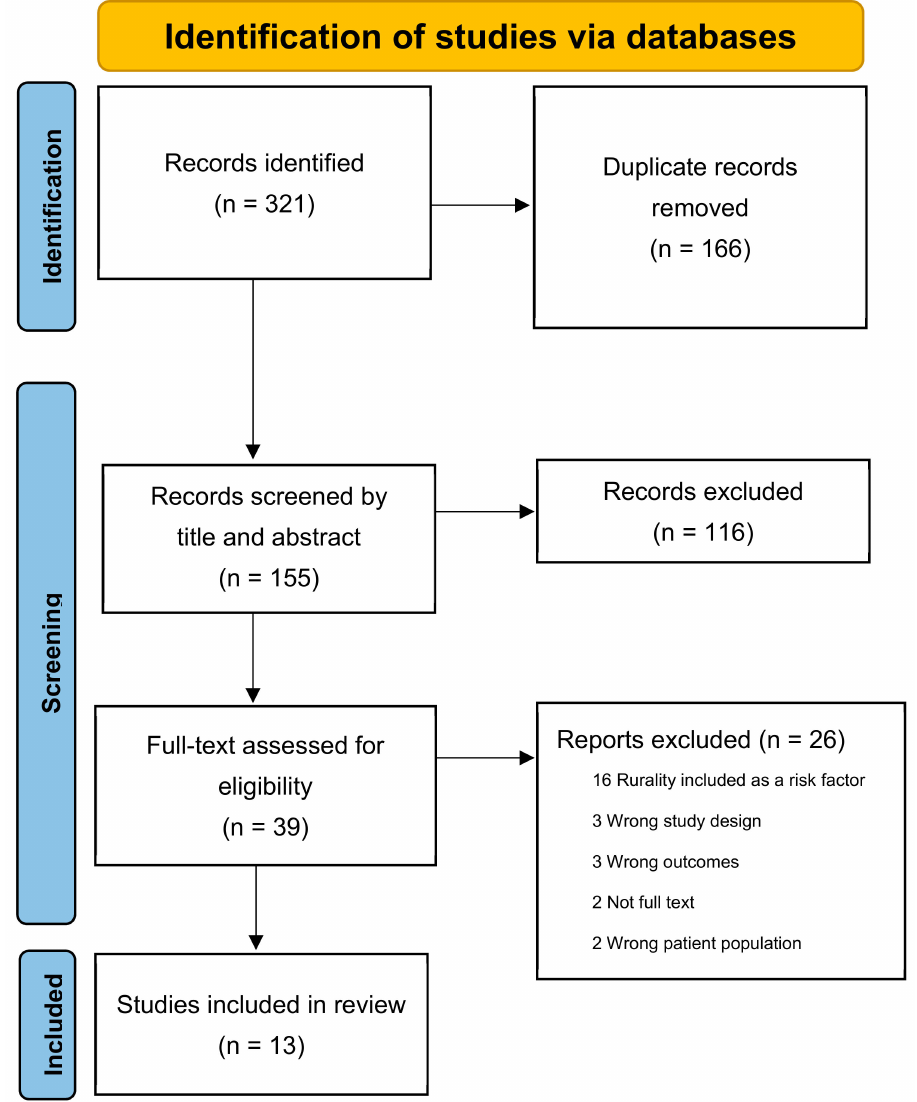
Figure 1. PRISMA flowchart for the